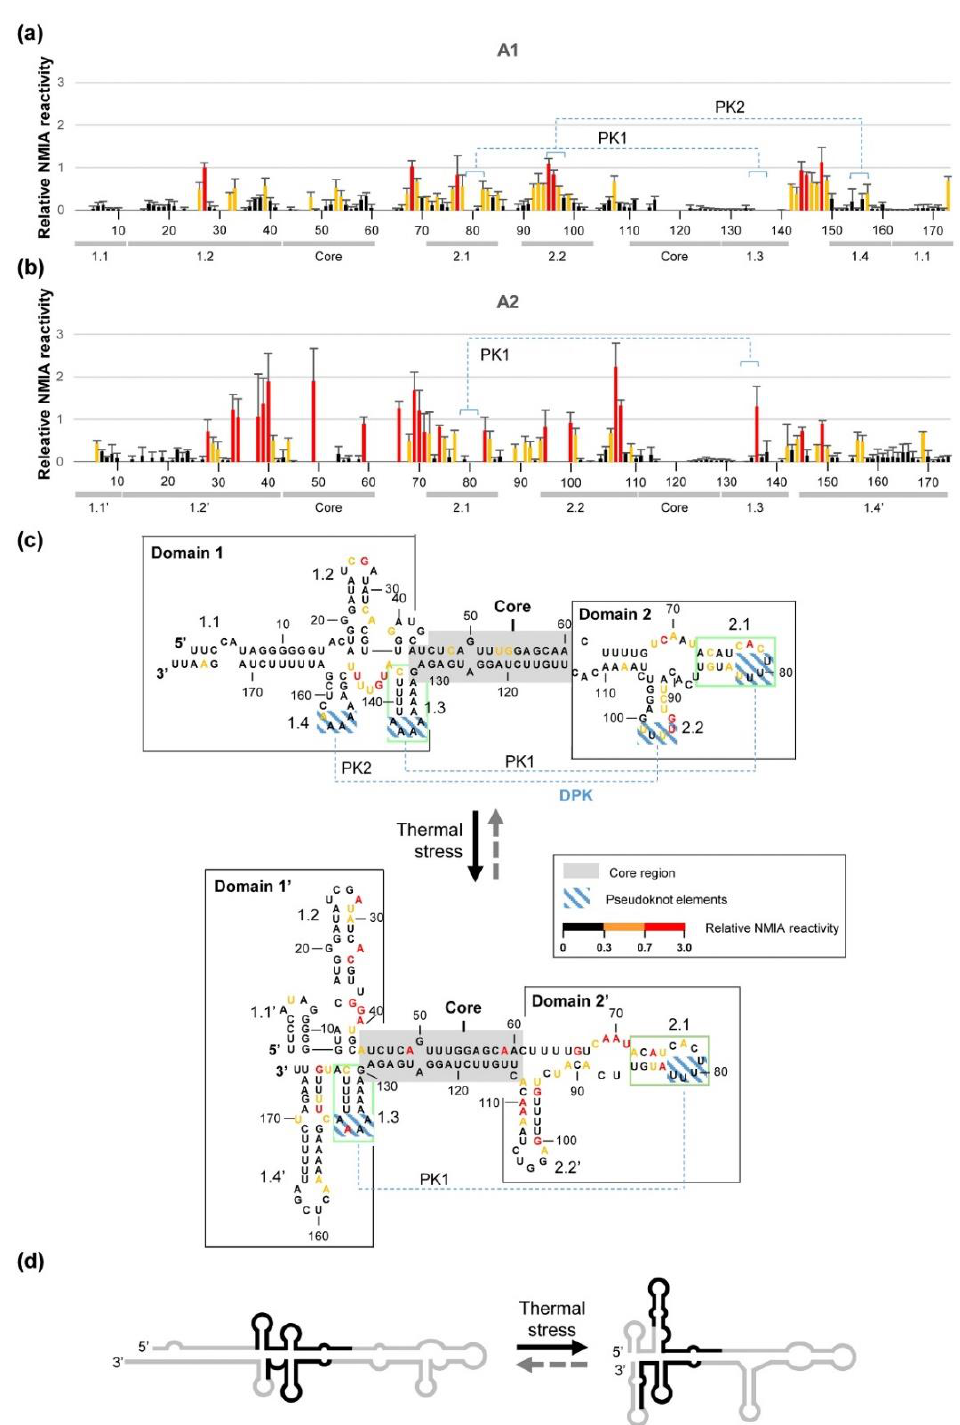
Figure 7. Structural analysis of the CriTER-A telomeric transcript by SHAPE. SHAPE reactivity of isolated conformers A1 ( a ) and A2 ( b ) of the CriTER-A telomeric transcript in the presence of Mg 2+ ions at 35 °C. Histograms show normalised reactivity. Colours denote relative nucleotide reactivity from black (lowest) to red (highest). Values are the mean of at least three independent experiments ± standard deviation. ( c ) Putative structure for CriTER-A conformers (A1 top, A2 bottom) predicted by RNAStructure based on SHAPE data. The core region is boxed in grey. Green boxes delimit those structurally preserved areas in both conformers. ( d ) Schematic representation of the secondary structure of CriTER-A, indicating with solid black lines the variable sequence stretches detected by comparative sequence alignment as described in Figure 2.